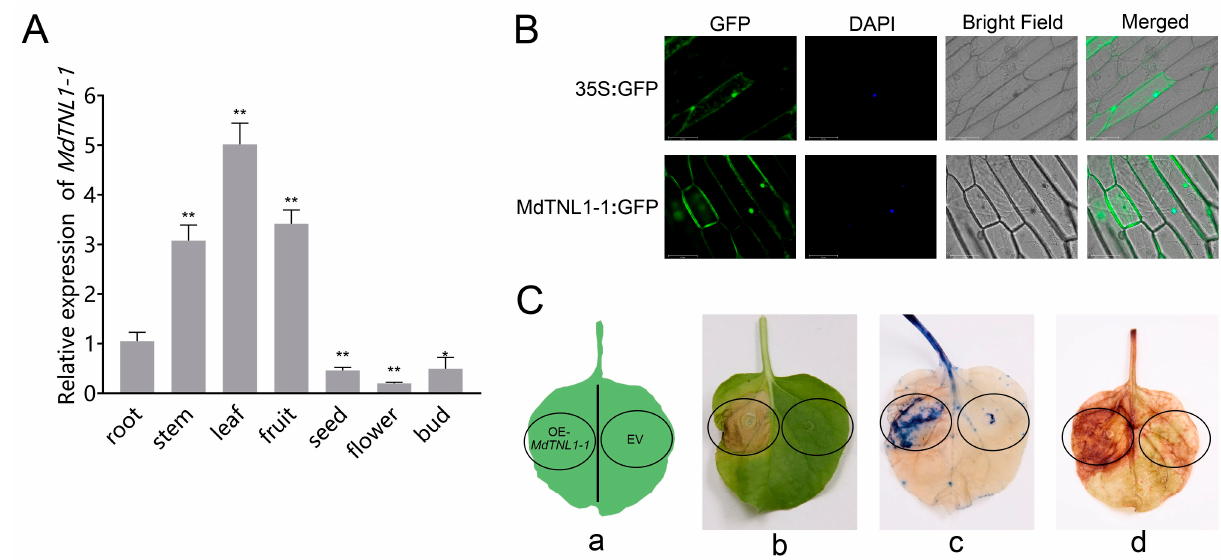
Figure 3. Expression analysis of MdTNL1-1 . ( A ) Differential expression of MdTNL1-1 in ‘Fuji’ apple tissues. Data are presented as the mean ± SD of three biological replicates. Asterisks indicate significant difference compared to root (* p < 0.05; ** p < 0.01, one-way ANOVA test by Tukey’s test). (B ) Subcellular localization of MdTNL1-1 protein. Full length CDS was fused with green fluorescent protein (GFP) and expressed in onion epidermal cells. Fluorescence was examined using confocal laser microscopy. Bars, 100 µ m. ( C ) Transient expression of MdTNL1-1 in Nicotiana benthamiana (tobacco) leaves. EV, infiltrated with Agrobacterium containing empty vector, pCAMBIA1300. OE- MdTNL1-1 , infiltrated with Agrobacterium harboring pCAMBIA1300- MdTNL1-1 . ( a ) Injection site of leaf. ( b ) Phenotype after 7 days of leaf injection. ( c ) Typan blue staining (TPB) of tobacco leaves 30 min after infiltration. ( d ) Diaminobenzidine staining (DAB) of tobacco leaves 4 h after infiltration. 2.4. MdTNL1-1 Was Required for the Resistance of Apple Plant to C.